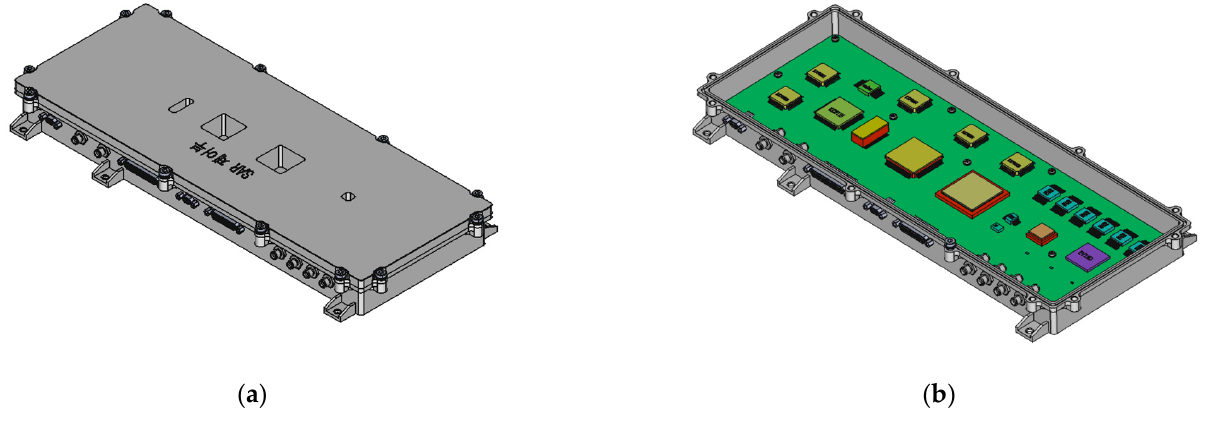
Figure 14. ( a ) External configuration and ( b ) internal configuration of the S-STEP DCU.